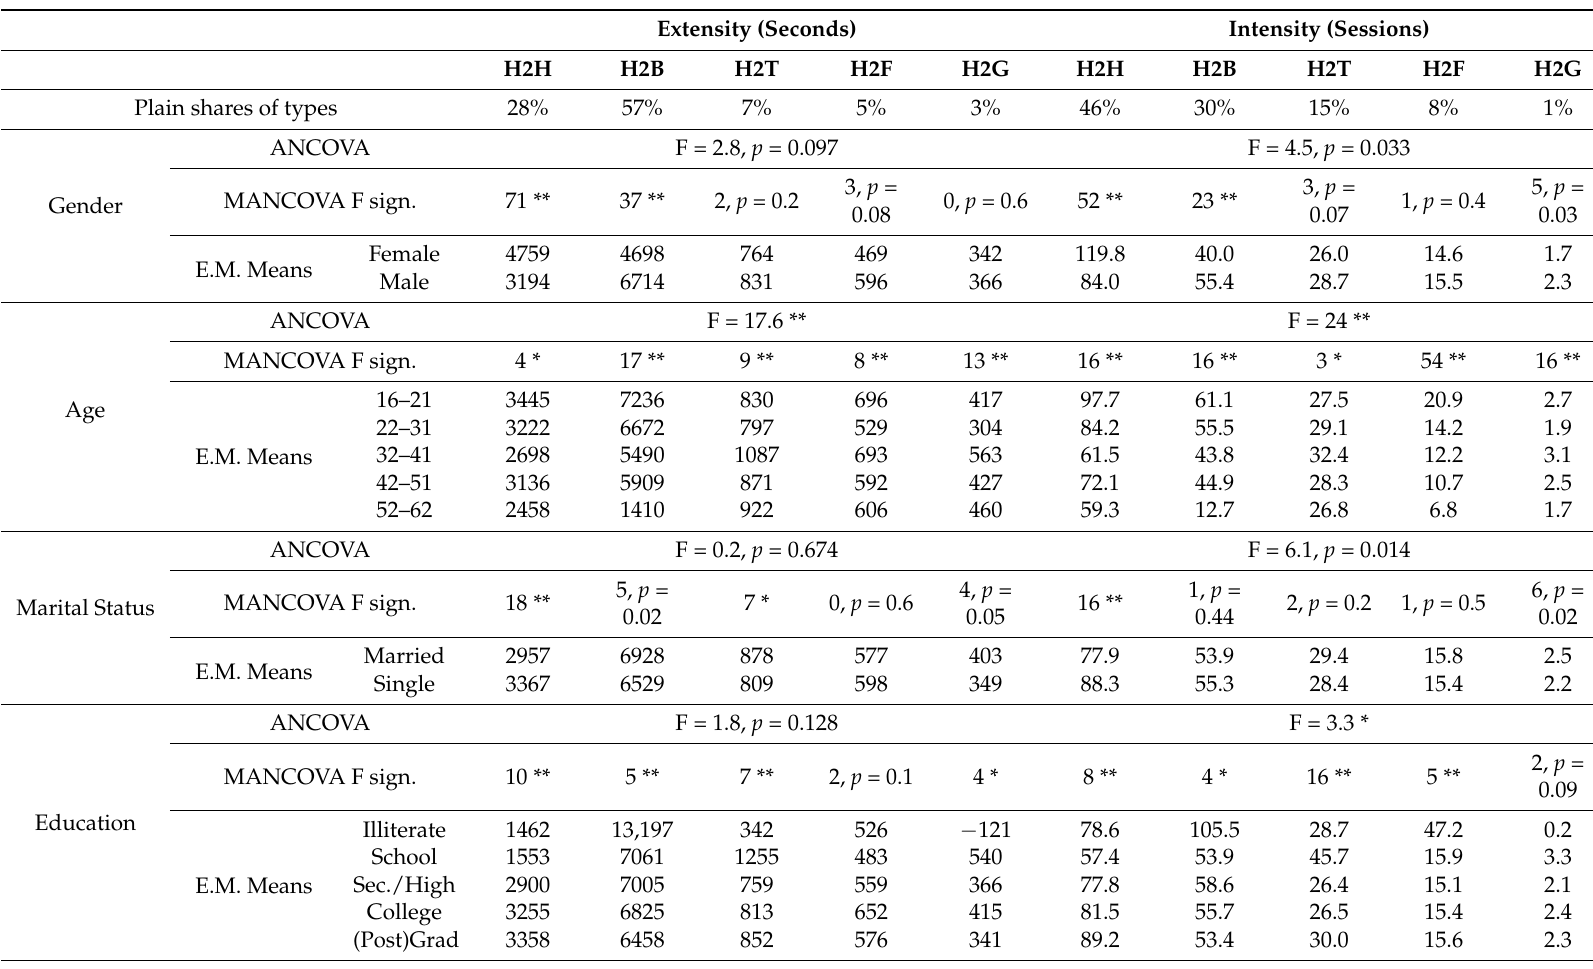
Table 1. ANCOVA and MANCOVA with socio-demographic fixed factors and ex- and intensities as dependent variables, each controlled for the remaining six socio-demographic covariates (* = p < 0.01; ** = p < 0.001; E.M. Means = MANCOVA Estimated Marginal